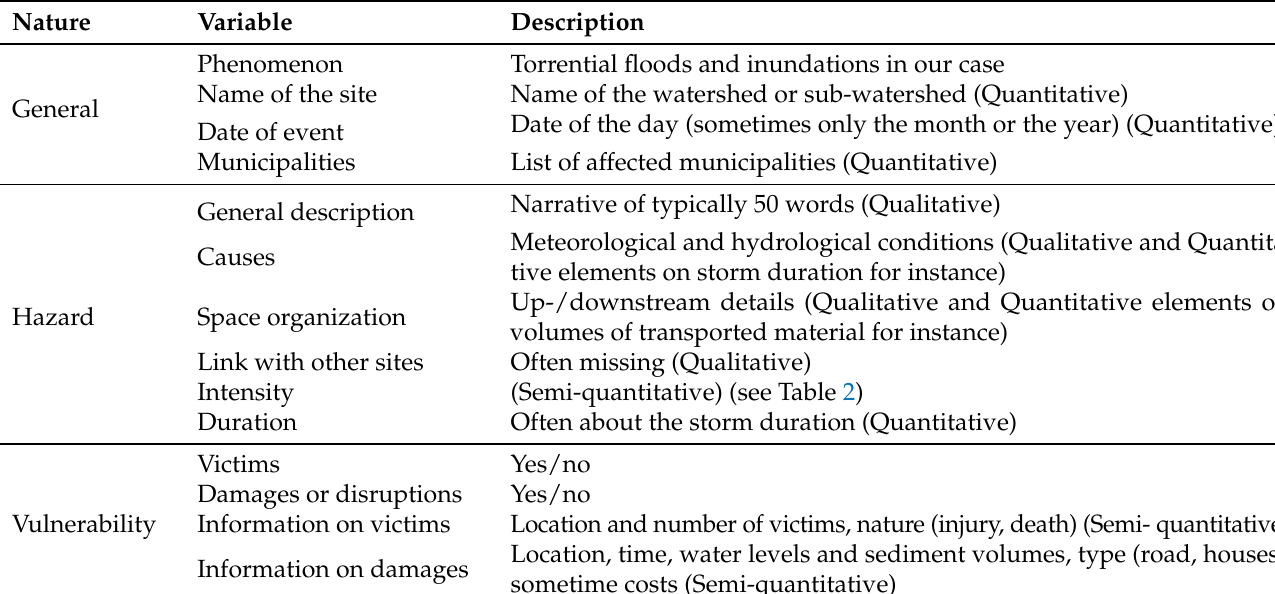
Table 1. Content of the RTM database for the description of an event at a site.